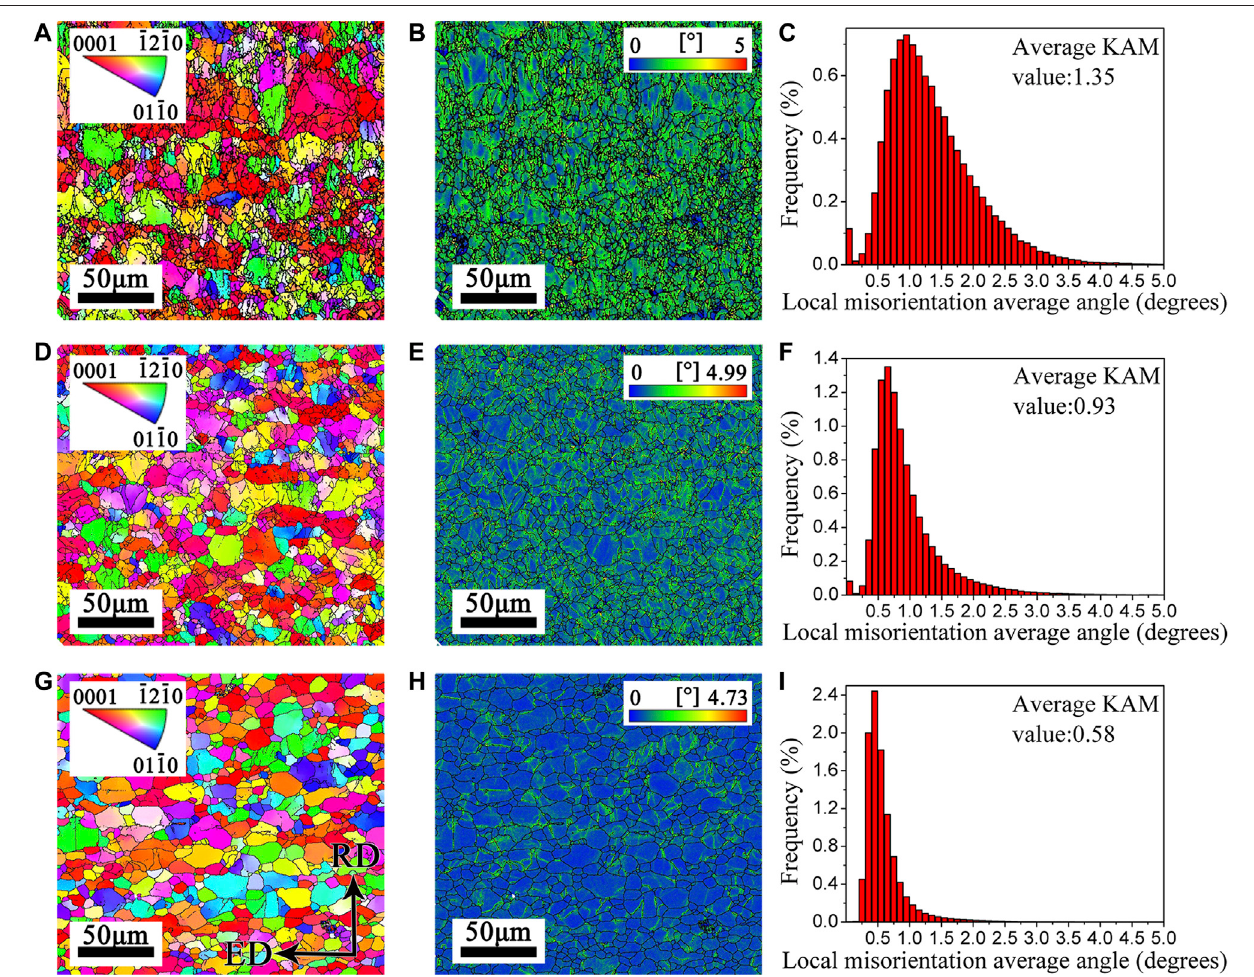
FIGURE 9 | KAM maps of the LAY410 alloy at the same rate with different temperatures: (A,B, and C) T (cid:2) 150 ° C, (D,E,F) T (cid:2) 200 ° C, (G,H,I) T (cid:2) 250 ° C.